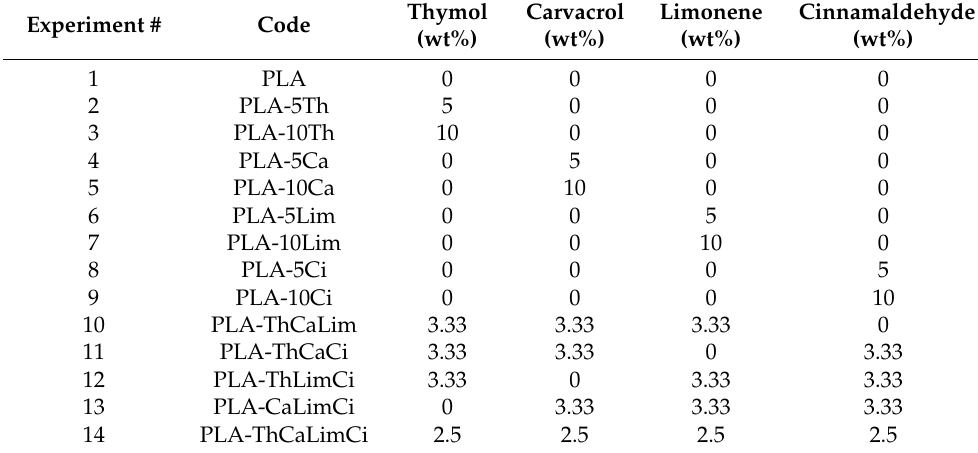
Table 1. Experimental design. Amount of additive(s) in the PLA matrix and their codename. Experiment